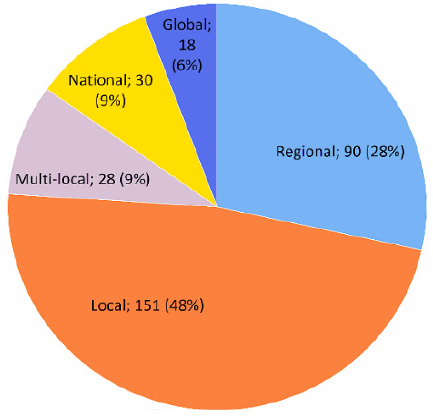
Figure 4. Distribution of selected articles at different spatial scales.